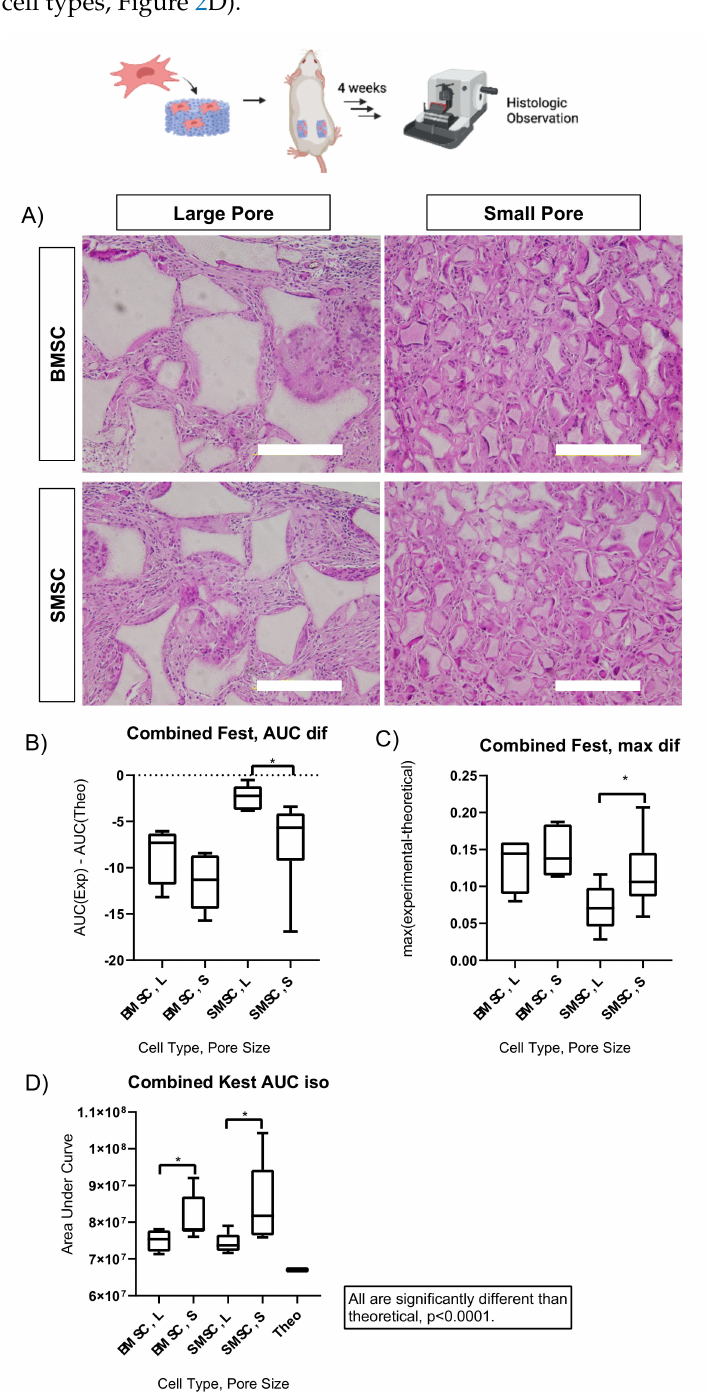
Figure 2. Schematic overview of the subcutaneous implantation study is shown at the top, leading to histologic observation. Hematoxylin and eosin-stained histologic sections from cell-laden scaffolds implanted subcutaneously in mice for 4 weeks (( A ), scale = 200 µ m) are used as inputs for first order ( B , C ) and second order ( D ) spatial point pattern analysis. Scheme created with Biorender. AUC = Area under the curve; Theo = theoretical. Fest = F-statistic (first order); Kest = K-statistic (second order). * = p <